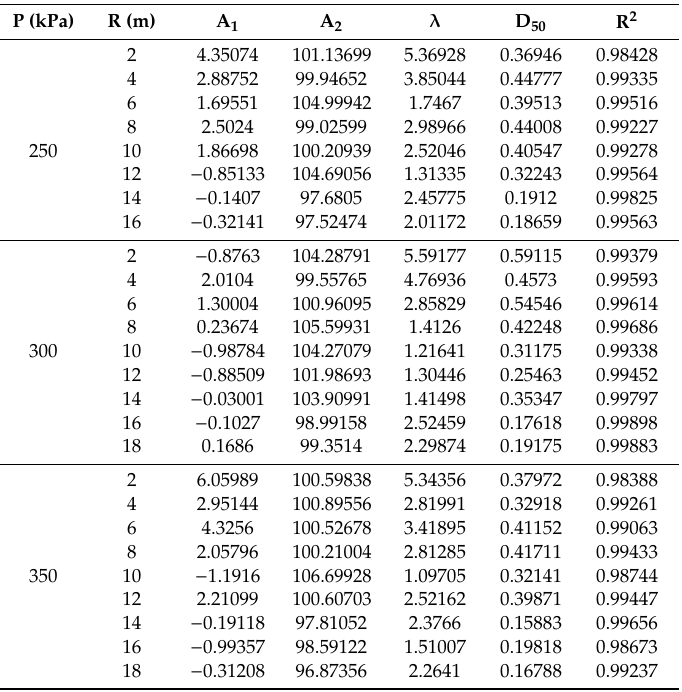
Table 2. Regression parameters A 1 , A 2 , λ , D 50 and R 2 for the model equation using the CNF at 250, 300, and 350 kPa operating pressures along the radial transect.